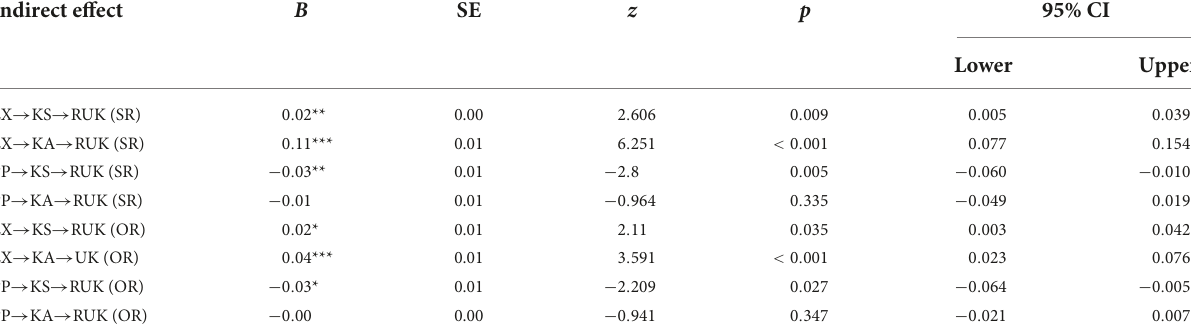
TABLE 2 Knowledge barriers mediator the indirect effects between the characteristics of knowledge sources and the performance of knowledge transfer. Indirect